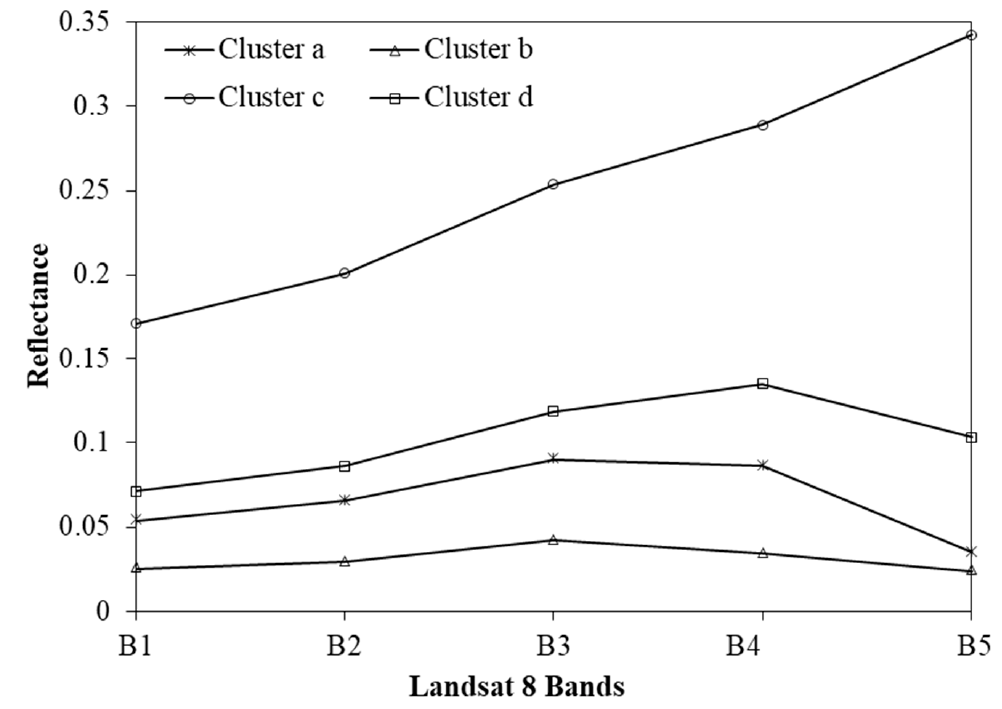
Figure 7. Centroid spectra curves of the clusters.